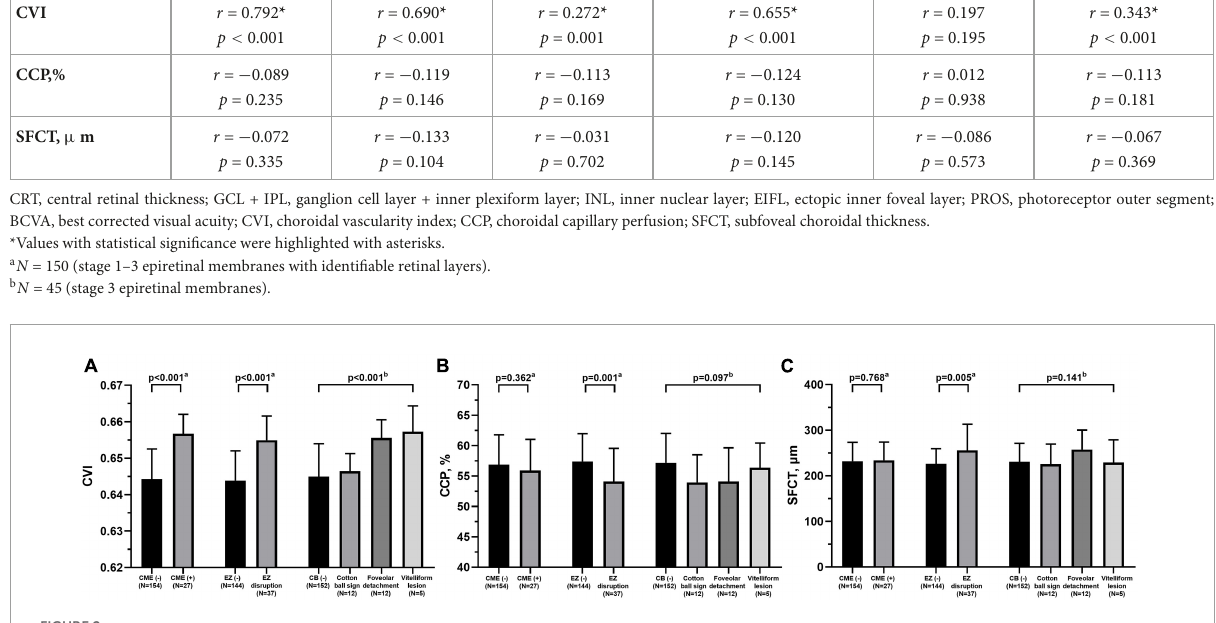
FIGURE2 Comparisons of choroidal parameters including CVI (A) , CCP (B) , and SFCT (C) between eyes with different retinal features under idiopathic epiretinal membrane conditions. CVI, choroidal vascularity index; CCP, choroidal capillary perfusion; SFCT, subfoveal choroidal thickness; CME, cystoid macular edema; EZ, ellipsoid zone; CB, central bouquet abnormality. a Mann-Whitney test. b Kruskal-Wallis